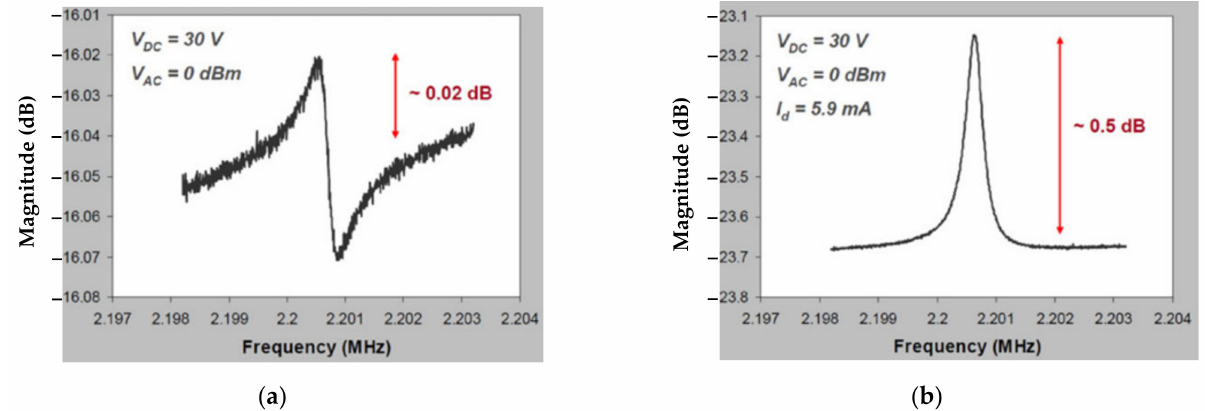
Figure 18. The frequency response measured for a BAW resonator with square extensional (SE) mode in the air (Adapted with permission from Ref. [95]). ( a ) One-port capacitive actuation and sensing method; ( b ) One-port capacitive actuation and piezoresistive sensing